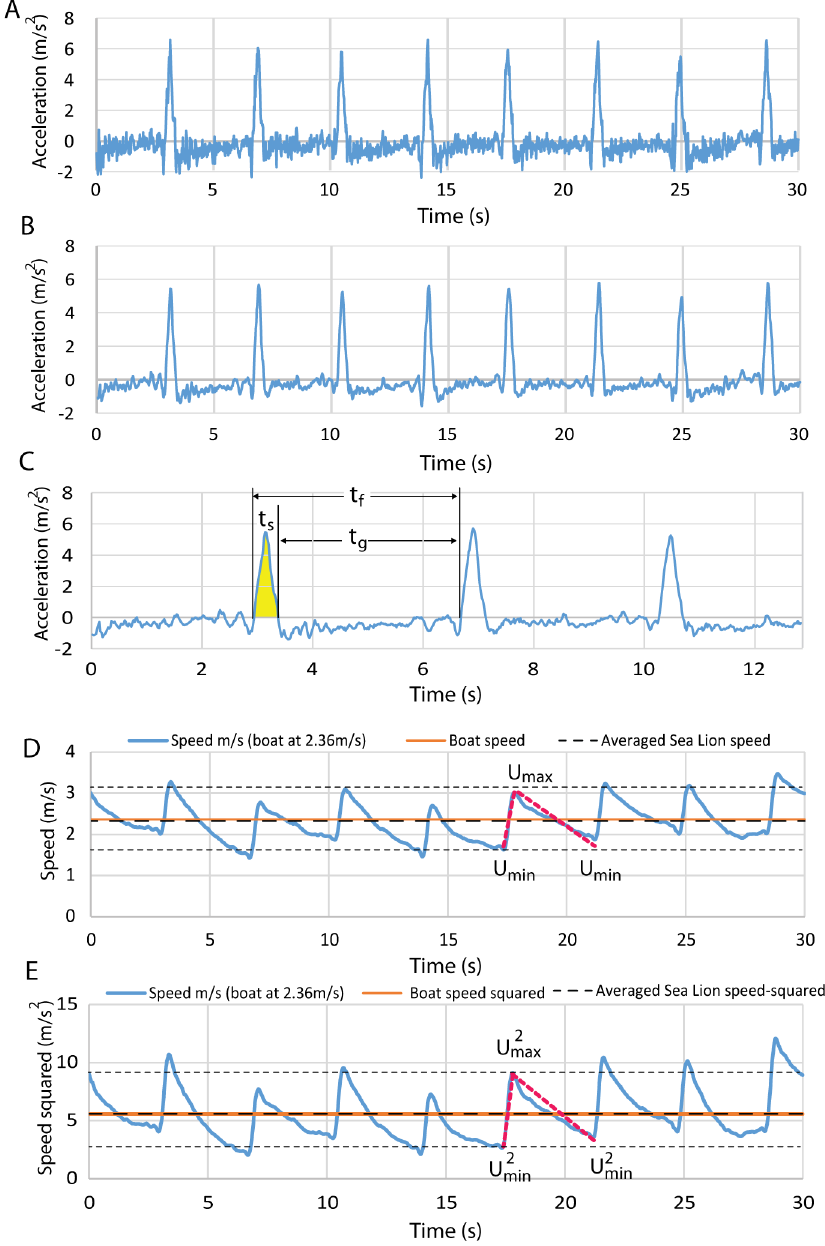
Fig 7. A series of strokes from an animal swimming at approximately 2.36 m/s. A) Forward acceleration (GIDA) sampled at 50 Hz. B) GIDA smoothed to 10 Hz. C) The area under the curve in the interval t s is the gain in speed from a stroke. The glide duration is t g and the duration of an entire stroke- glide cycle is t f . D) Speed obtained by integrating the smoothed acceleration data. The model is indicated by the red dashed line. E) Speed squared from the same data. Horizontal dashed lines represent the averaged MIN and MAX